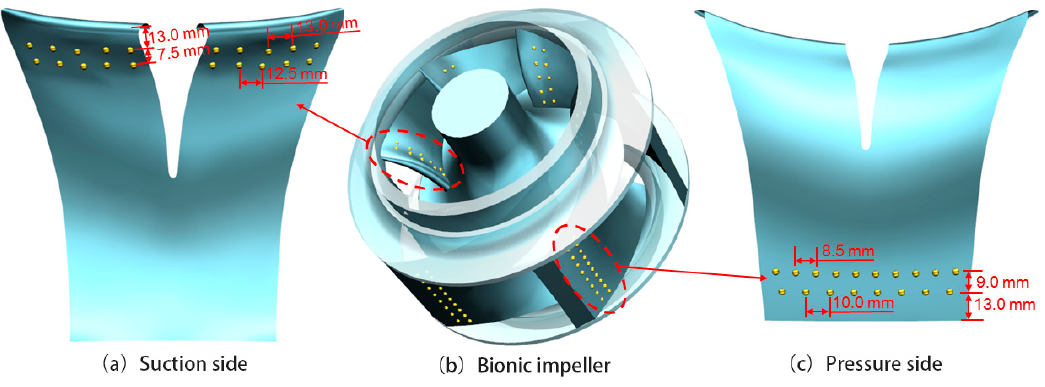
Figure 2. Sketch of bionic impeller with bionic convex domes.